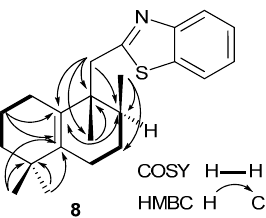
Figure 1. Selected COSY and HMBC correlations for compound 8 .